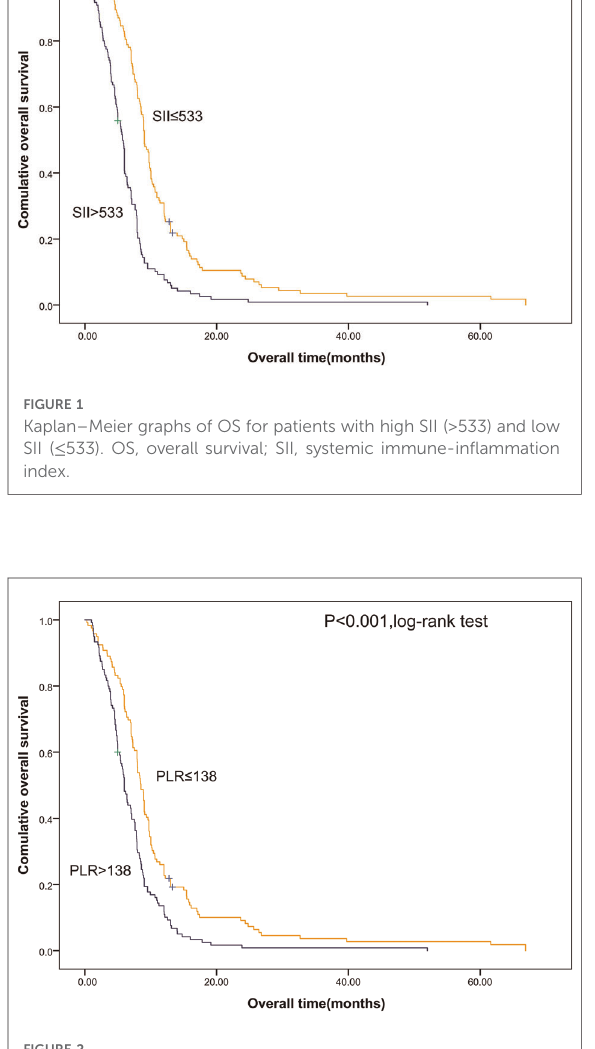
FIGURE 2 Kaplan – Meier graphs of OS for patients with high PLR (>138) and low PLR ( ≤ 138). OS, overall survival; PLR, platelet/lymphocyte